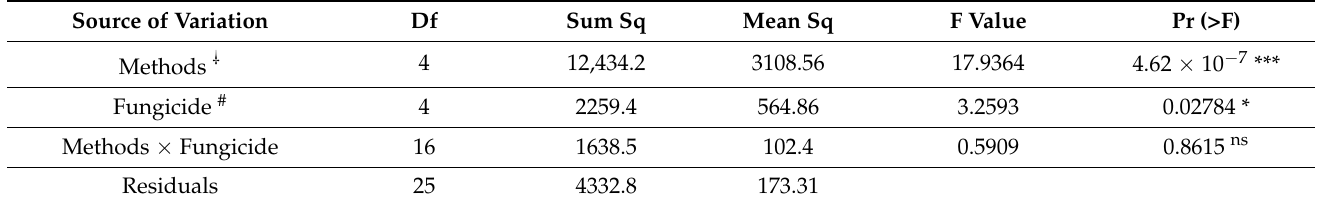
Figure 4. Evaluation of fungicide efficacy and application methods in controlling Phytophthora blight of pigeonpea seedlings on susceptible ICP 7119 cultivar. Figure 3. Evaluation of fungicide efficacy against Phytophthora blight of pigeonpea seedlings. ( a ) Zoospore-inoculated positive control; ( b ) non-inoculated negative control. ( c ) Overview of the zoospore-inoculated seedlings with different fungicide treatments. Table 4. Analysis of variance (ANOVA) evaluating the effects of different fungicides and their different application methods for controlling the Phytophthora blight of pigeonpea seedlings in a susceptible ICP 7119 cultivar.